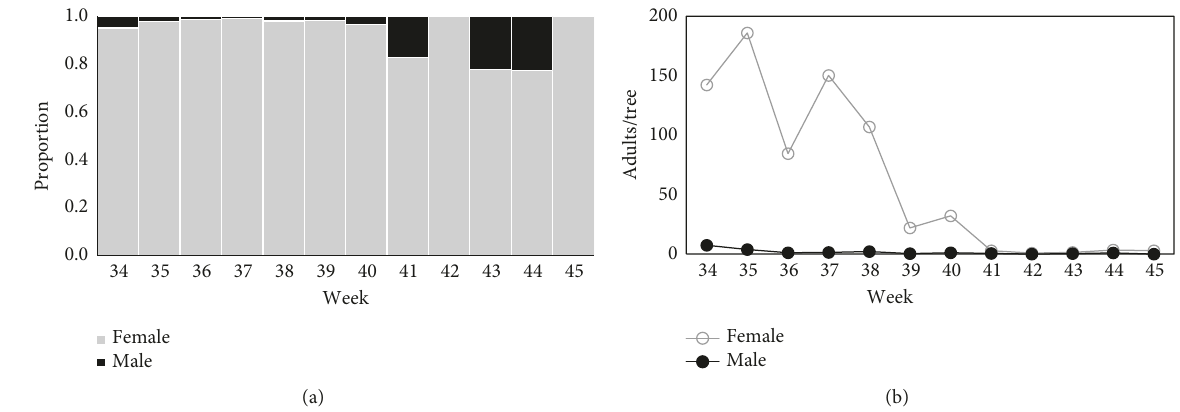
Figure 6: Seasonal sex ratio of Lycorma delicatula (a) by proportion and (b) by